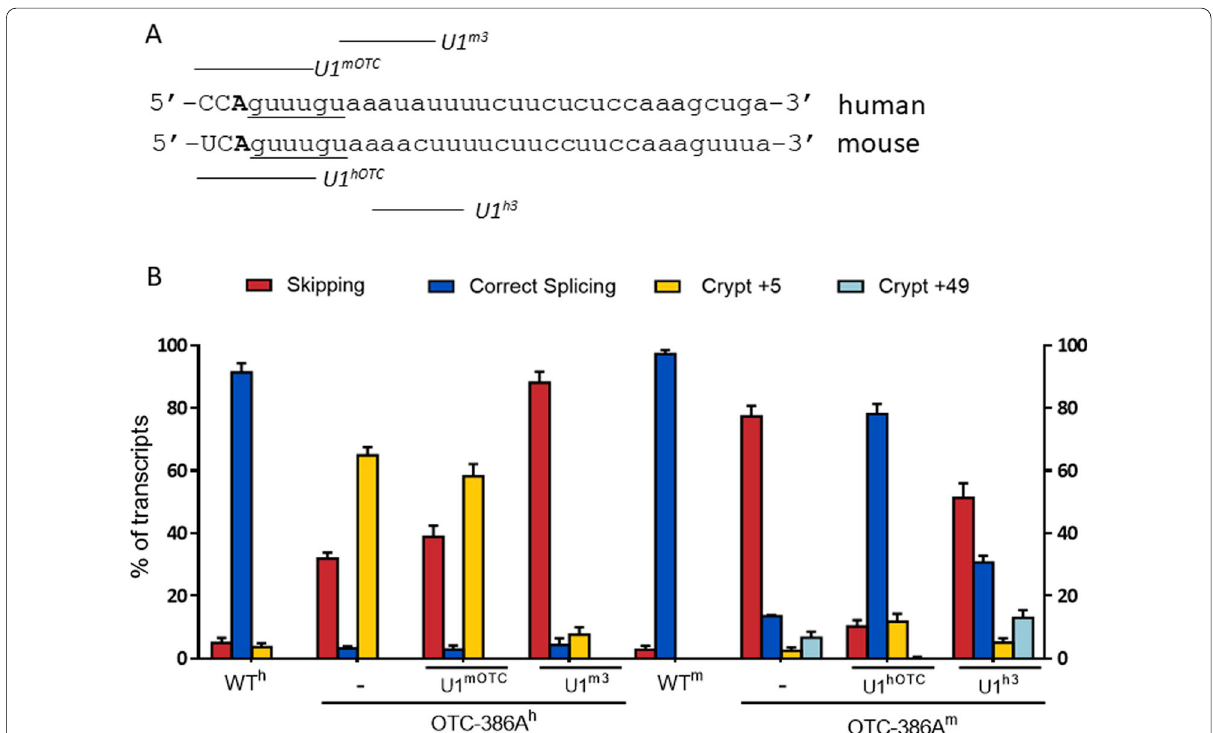
Fig. 6 Cross-activity of the human and mouse tailored U1snRNAs. A Pre-mRNA sequences of the human and mouse OTC exon 4 exon–intron junctions, with exonic and intronic nucleotides in upper and lower cases, respectively. The regions targeted by the 5 ′ tail of the modified U1snRNAs are reported (solid line). The c.386G>A change is indicated in bold. B The bar plots report the splicing patterns in HepG2 or Hepa1-6 transiently transfected with the OTC-386A h (left) or OTC-386A m (right) minigenes, respectively, and challenged with the U1 variants. Bar plots indicate the relative percentage of each transcript, and results are expressed as mean SD from three independent ±